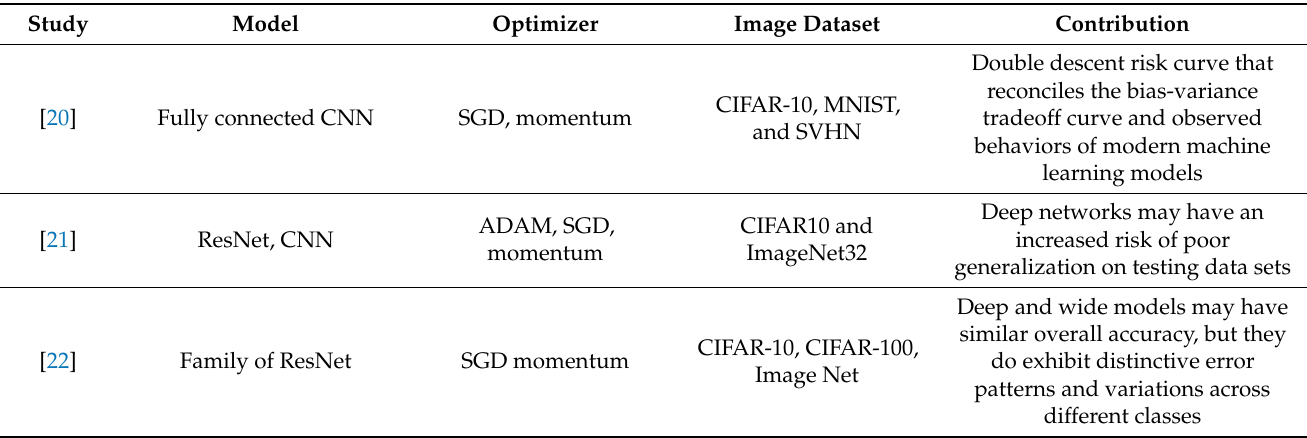
Table 1. Summary of relevant